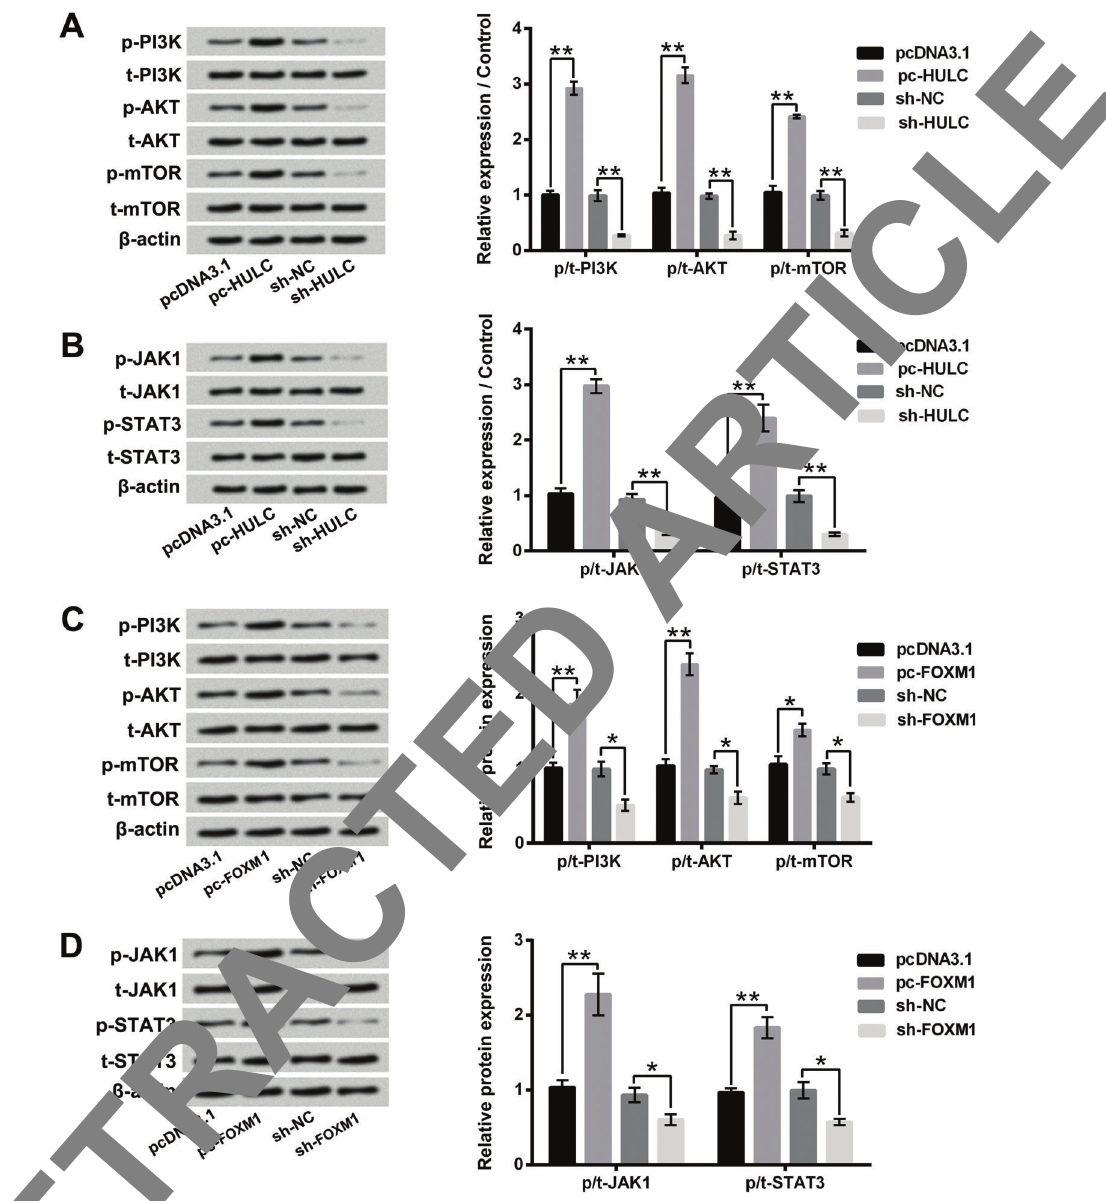
Figure 7. Overexpression of FOXM1 activated PI3K/AKT/mTOR and JAK1/STAT3 pathways in GH3 cells. ( A and B ) The expression levels of p-PI3K, t-PI3K, p-AKT, t-AKT, p-mTOR, t-mTOR, p-JAK1, t-JAK1, p-STAT3, and t-STAT3 in GH3 cells after pc-HULC or sh-HULC transfection were evaluated using western blotting. ( C and D ) The expression levels of the same proteins in GH3 cells after pc-FOXM1 or sh-FOXM1 transfection were evaluated using western blotting. HULC: Highly up-regulated in liver cancer; FOXM1: forkhead box protein M1; NC: negative control; PI3K: phosphatidylinositol 3-kinase; AKT: protein kinase 3; mTOR: mammalian target of rapamycin; JAK1: janus kinase 1; STAT3: signal transducing activator of transcription 3. Data are reported as means ± SD.*P o 0.05; **P o 0.01 Abnormal hormone secretion is one of the major secret PRL and GH (33). Therefore, we also assessed the complications of secreting pituitary adenomas (32). As a PRL and GH levels in culture supernatant of GH3 cells rat secreting pituitary adenoma cell line, GH3 can also after HULC overexpression or knockdown. Taken together,